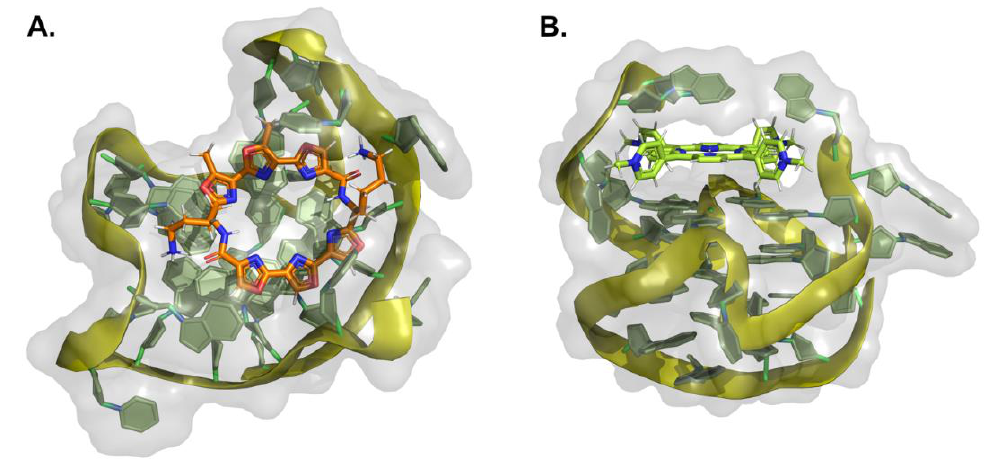
Figure 12. Structural representations of the complexes between different macrocycles and G4s. ( A ) top view of telomestatin derivative 3,3-L2H2-6OTD interacting with the telomeric DNA G4 (PDB 2MB3). ( B ) side-view of a cationic porphyrin derivative interacting with a parallel DNA G4 (PDB 2A5R). All the ligands are represented as colored sticks, while the G4s are represented as cartoon and transparent surfaces.